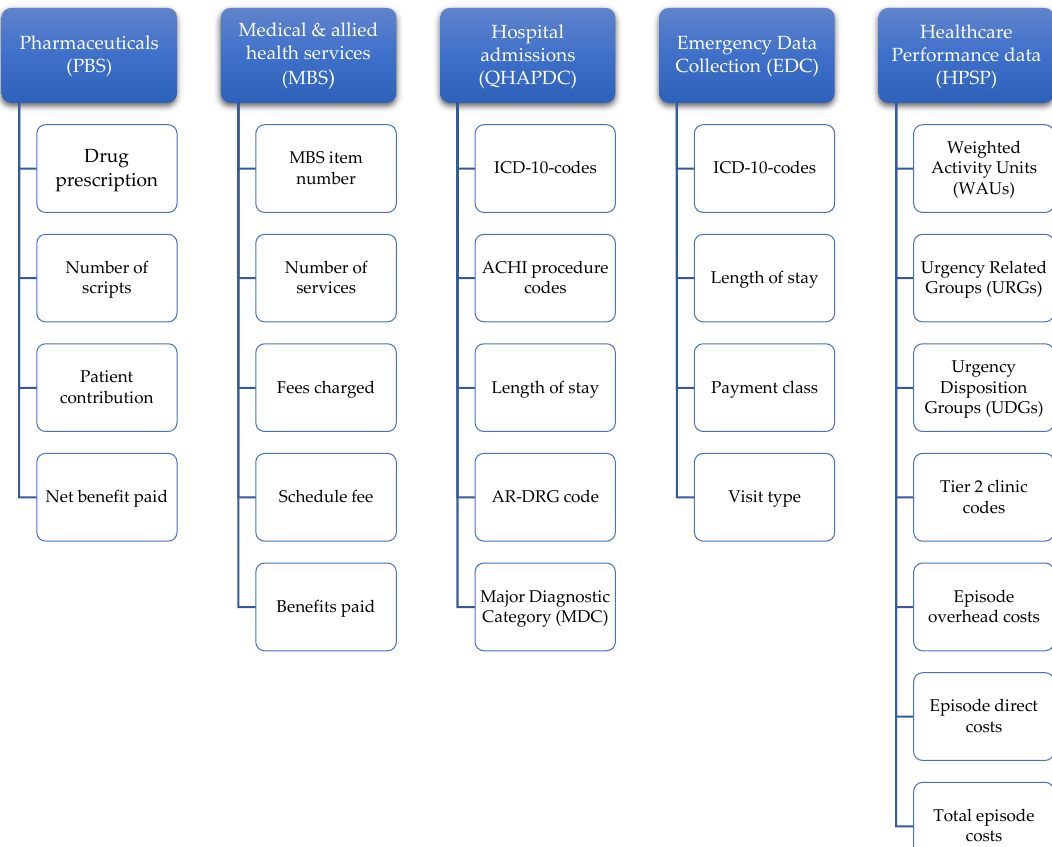
= Pharmaceutical Figure 2. Individual cost components part of bottom-up costing model * . Figure 2. Individual cost components part of bottom-up costing model *. * PBS Benefit Scheme; MBS = Medical Benefit Scheme; QHAPDC = Queensland Hospital Admitted Patient Data Collection; HPSP = Healthcare Purchasing and System Performance Data; ICD-10 = International Classification of Diseases, 10 th Revision; ACHI = Australian Classification of Health Interventions; AR-DRG = Australian Refined Diagnosis Related